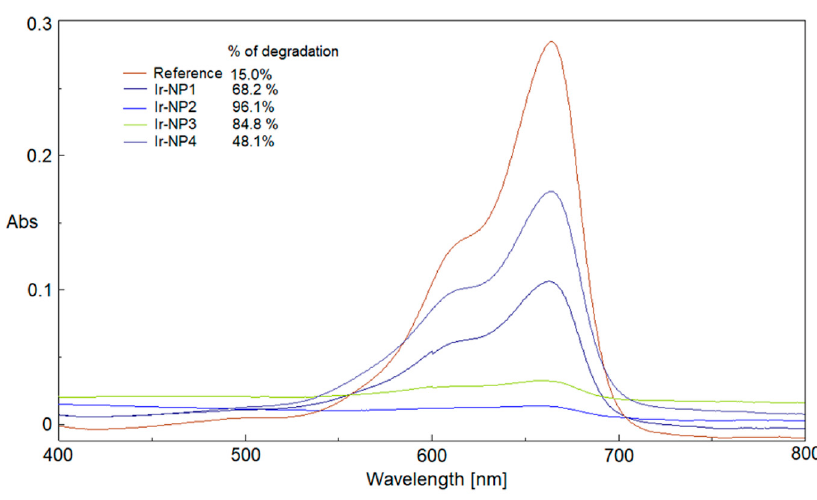
Figure 7. Catalytic comparison between reference and Ir-NPs at 6 min, and % of MB reduction. Table 3. The specific rate constant of catalytic reduction of MB by NaBH 4 for reference, in the presence of extracts (GM1, GM2, GM3, and GM4), and the presence of iridium nanoparticles (Ir-NP1, Ir-NP2, Ir-NP3, and Ir-NP4). Experiments were conducted in